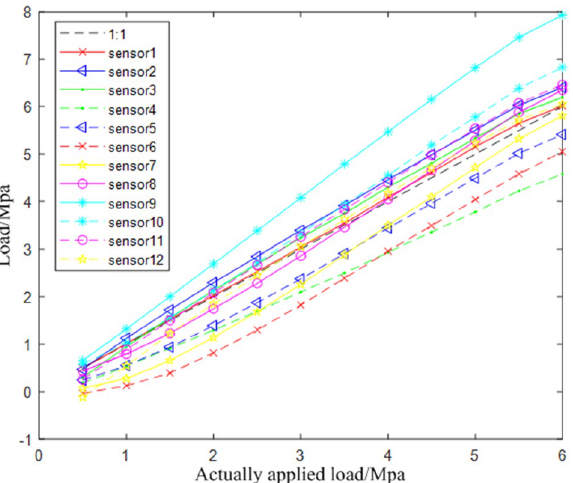
Figure 16. Relationship curve between applied load and detected load of axial pressure.